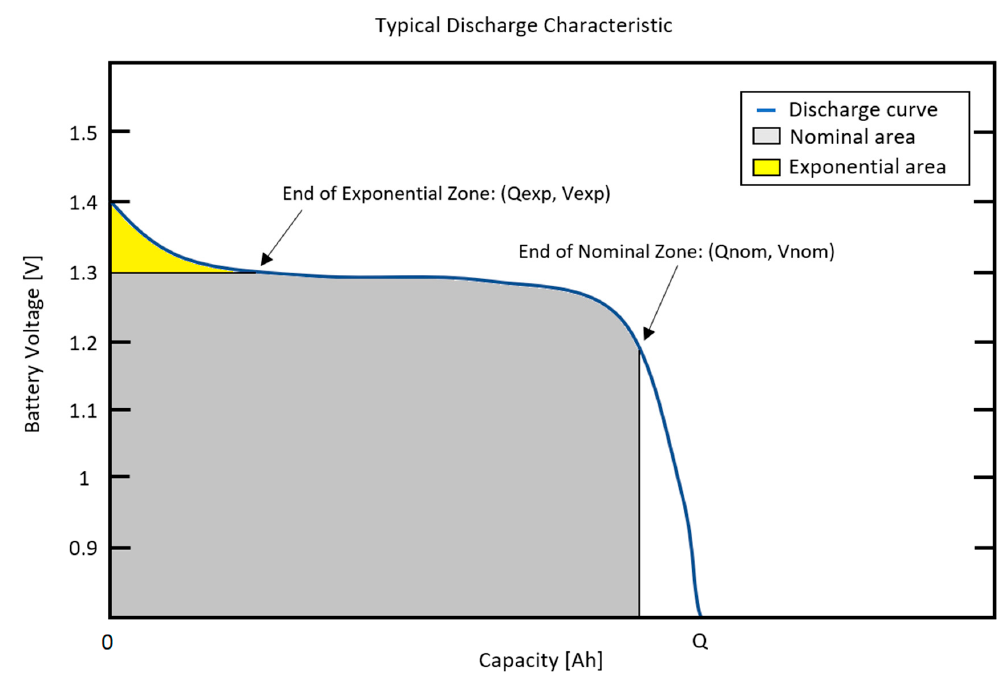
Figure 5. Battery discharge voltage [51].